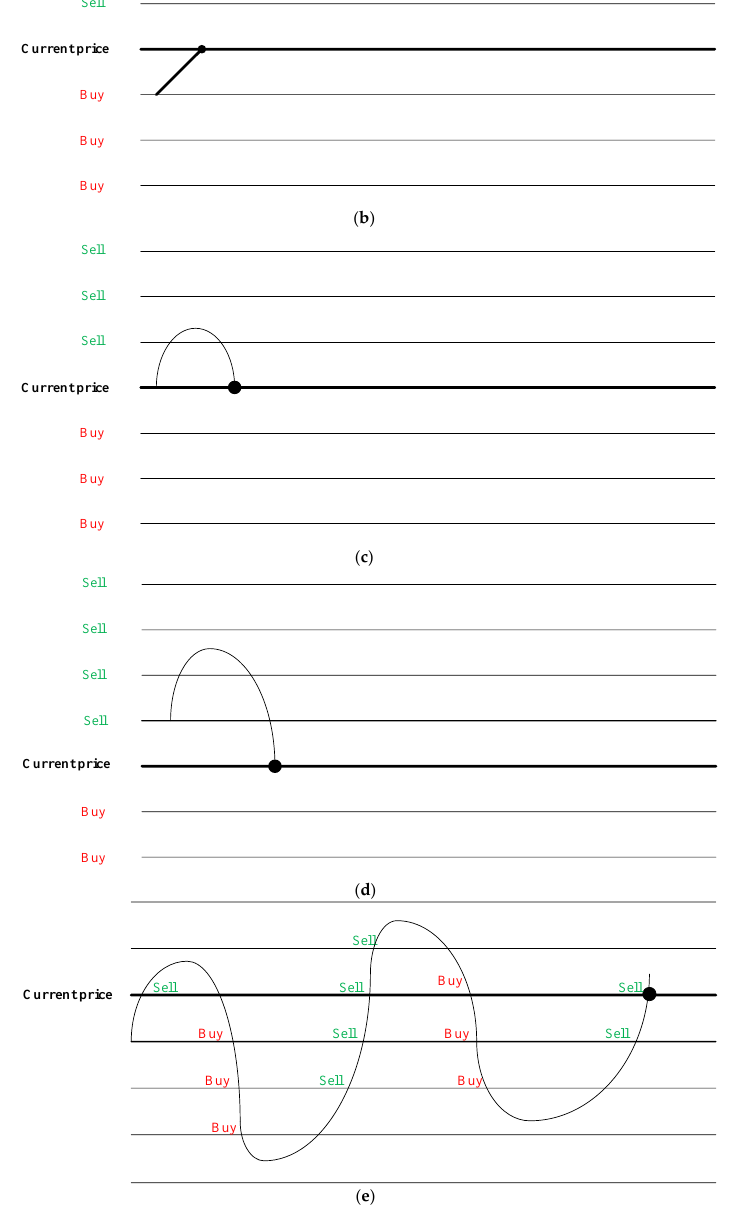
Figure 3. Grid trading operation chart ( a – e ).